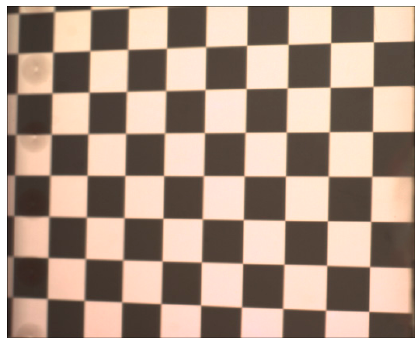
Figure 7. Captured virtual checkerboard image reflected by the mirror.